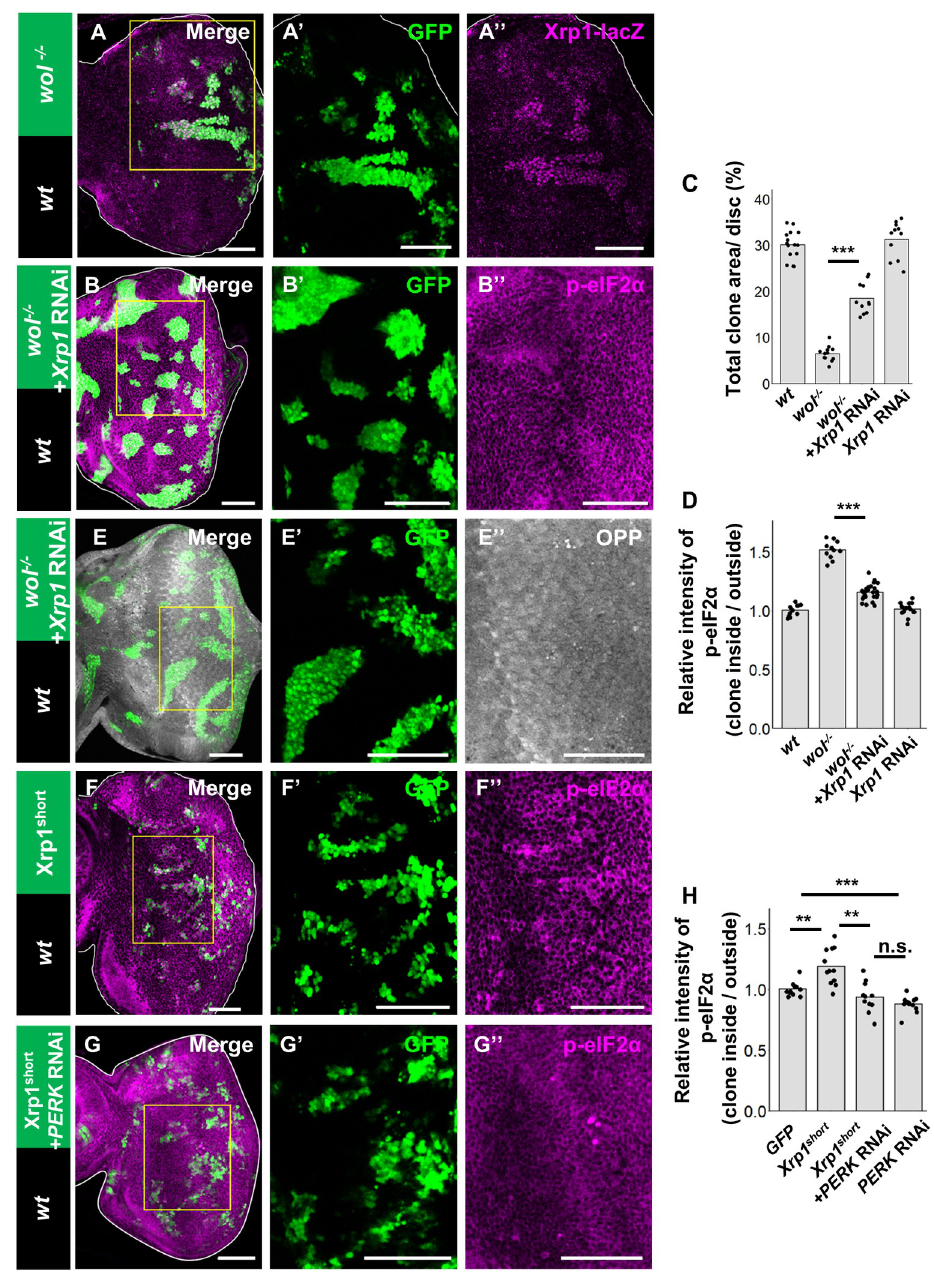
Fig 3. ER stress upregulates Xrp1, which causes PERK-mediated eIF2 α phosphorylation. (A) Xrp1-lacZ/+ eye disc bearing eyFLP-induced MARCM clones of wol ccp-28-/- stained with anti- β -gal. (B) Eye disc bearing eyFLP-induced MARCM clones of wol ccp-28-/- + Xrp1-RNAi cells stained with anti-phosphorylated eIF2 α . (C) Quantification of the relative size of GFP-labeled clones shown in A and B. Error bars, SD; ��� p < 0.001 by Welch’s t-test. (D) Quantification of the relative intensity of anti-phosphorylated eIF2 α staining in clones shown in A and B. Error bars, SD; ��� p < 0.001 by Welch’s t-test. (E) Eye disc bearing eyFLP-induced MARCM clones of wol ccp-28-/- + Xrp1-RNAi cells stained with OPP labeling. (F and G) Eye disc bearing eyFLP-induced MARCM clones of UAS-Xrp1 short (F) [46] or UAS-Xrp1 short + PERK-RNAi (G) cells stained with anti-phosphorylated eIF2 α . (H) Quantification of the intensity of anti- phosphorylated eIF2 α staining in clones shown in F, G, and Fig 4B. Error bars, SD; ��� p < 0.001 by Steel-Dwass test. Scale bars, 50 μ m. See S1 Text for detailed genotypes.